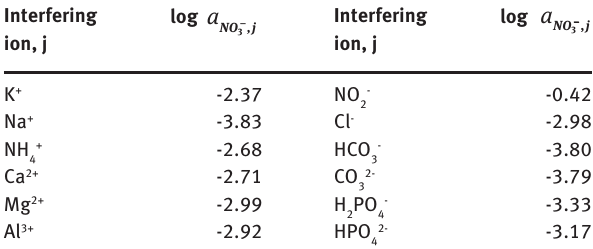
Table 3 Nitrate content of studied natural surface water